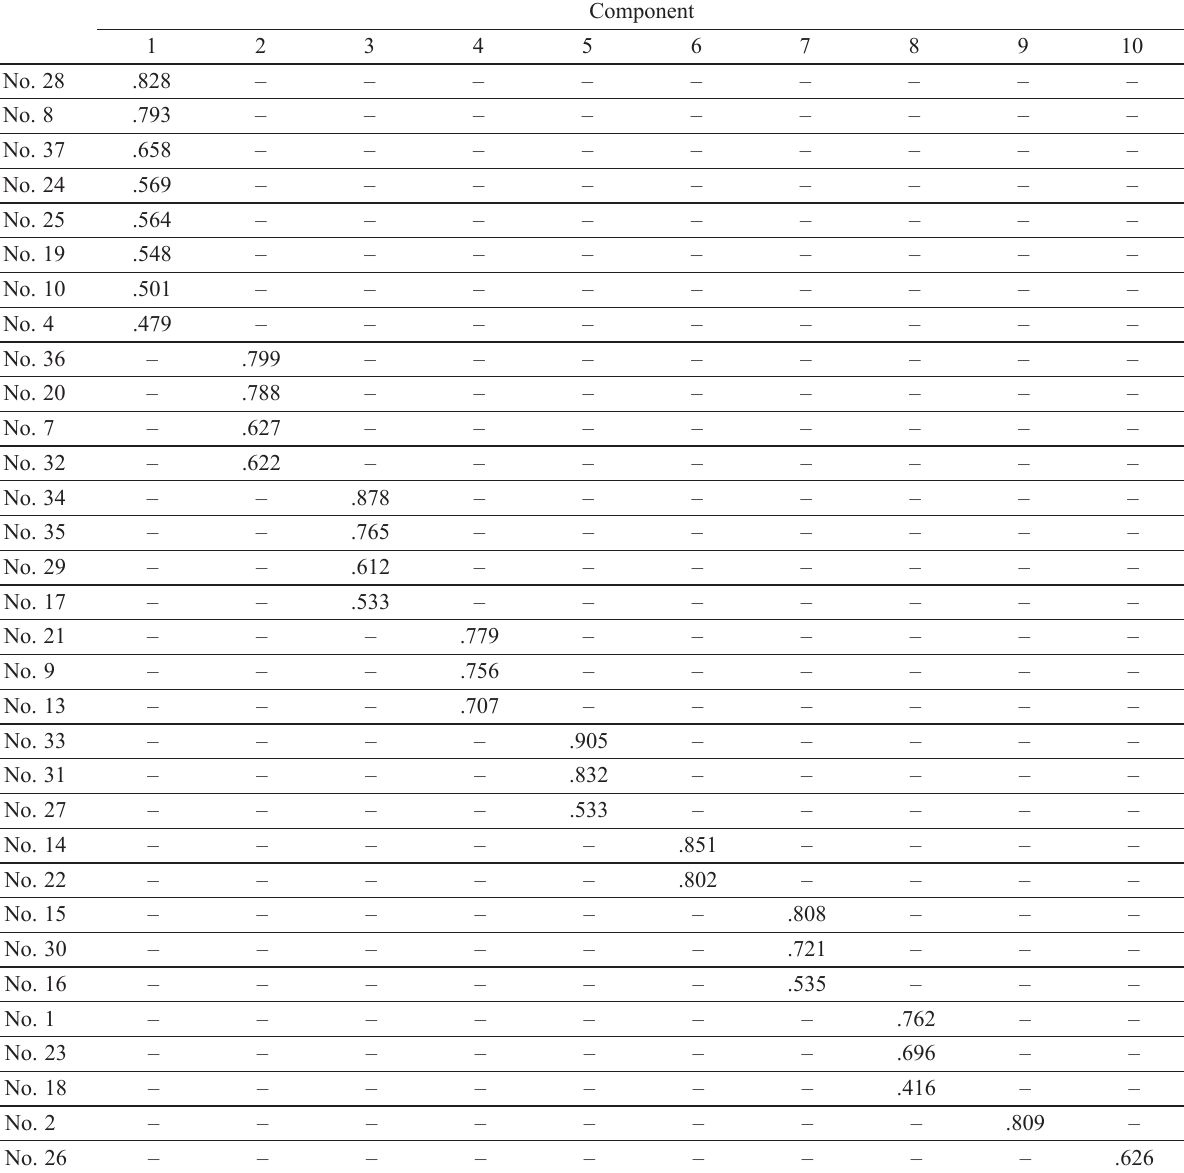
Table 6. Rotated component matrix for measurement factors of employee participation in